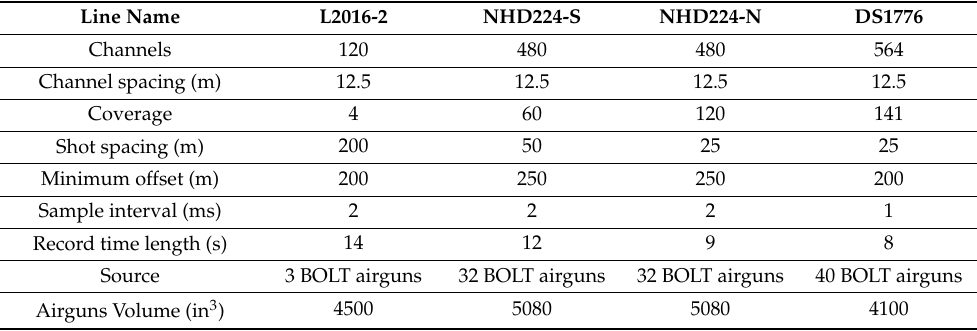
Table 1. Acquisition parameter of